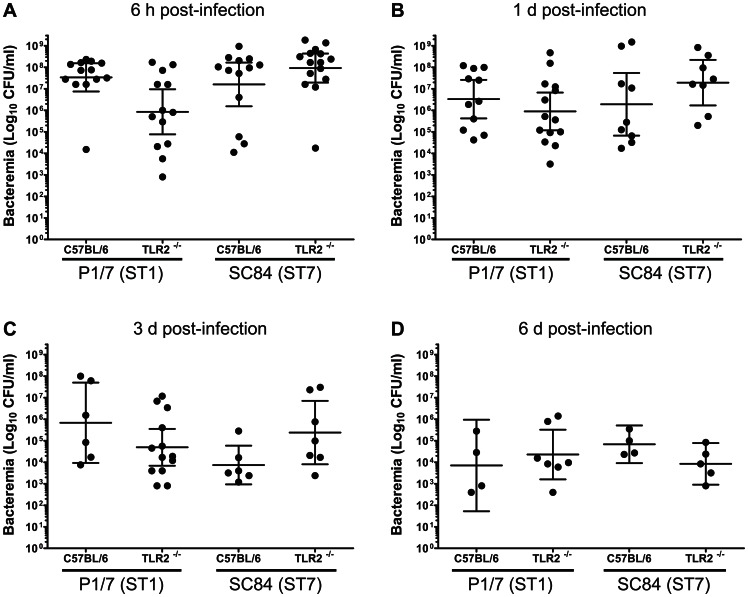
Blood bacteremia of S.
suis highly virulent strain ST1 and epidemic strain ST7 is similar in C57BL/6 and TLR2−/− mice.C57BL/6 mice (n = 13 mice per group) or TLR2−/− mice (n = 14 mice per group) were inoculated by intraperitoneal injection with 1×107 CFU of either S. suis strain P1/7 (ST1) or SC84 (ST7). At 6 h (panel A), day 1 (panel B), day 3 (panel C), and day 6 (panel D) post-infection, 5 μl of blood was harvested from the tail of infected mice and proper dilutions were plated on blood agar plate to assess blood bacteremia. Data of individuals are presented including geometric mean with 95% confidence interval. No significant differences (P>0.05) between infected TLR2−/− mice and their WT counterpart were observed as determined by ANOVA.